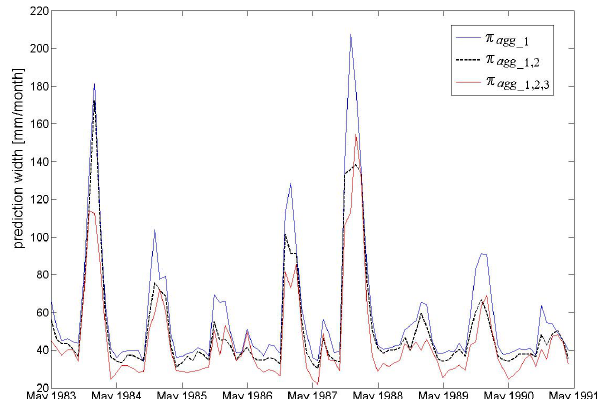
Fig. 9. Prediction width at the possibility level α =0.90 for the aggregate possibility distributions π agg 1 , π agg 1 , 2 and π agg 1 , 2 , 3 during the verification period.